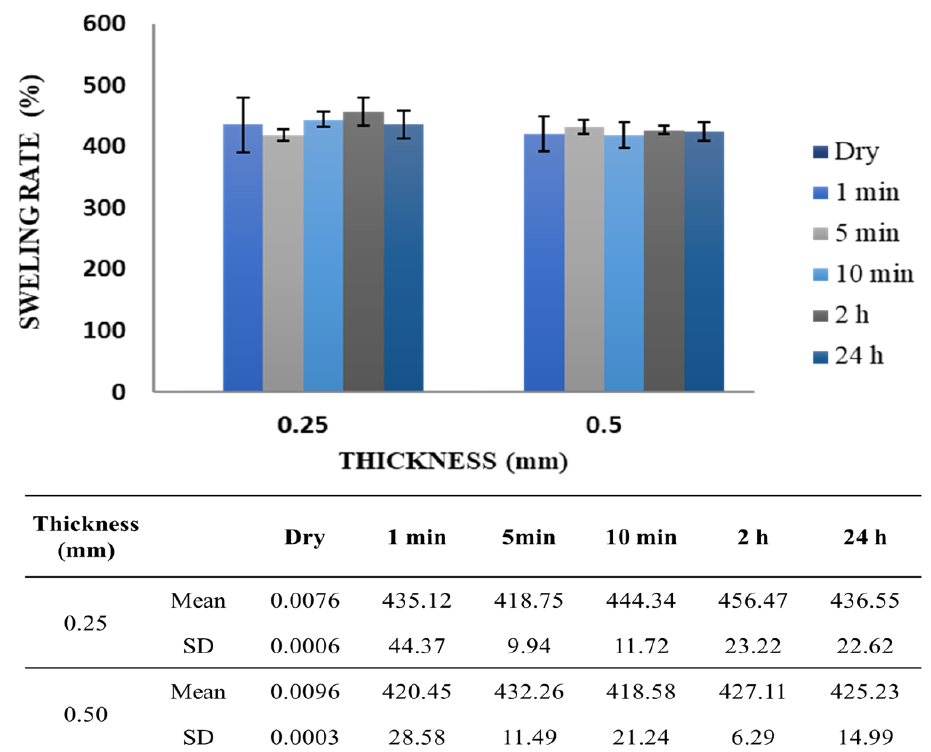
Figure 3. Swelling analysis of the 0.25- and 0.5- mm PDO membranes over time. The percentages were calculated in relation to the dry mass of the membrane. were calculated in relation to the dry mass of the membrane.